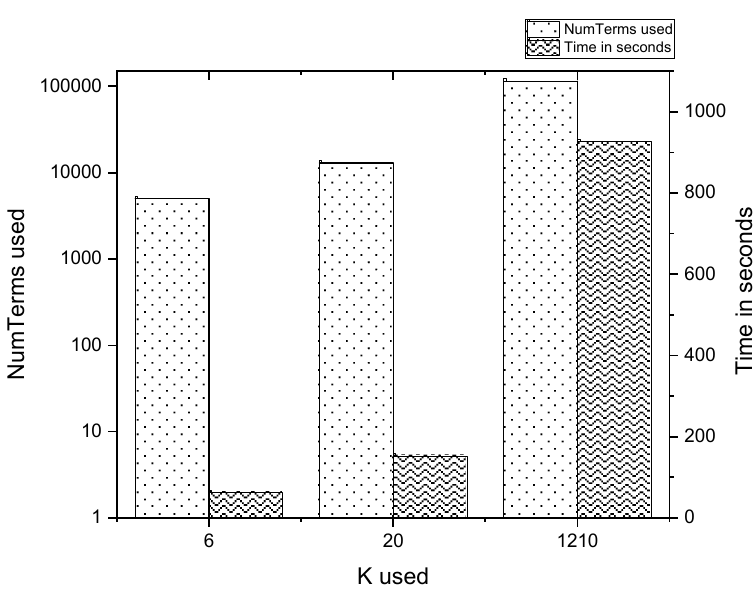
Figure 4. Average execution time based on number of concepts and terms for 5-node clusters.